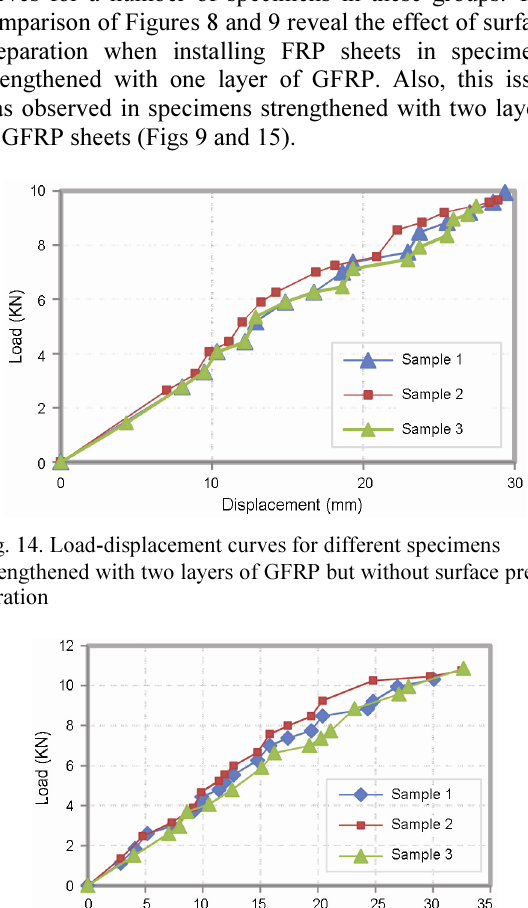
Fig. 19. Load-displacement curves for FRP-strengthened speci- mens with two layers of GFRP and with longitudinal grooves of 6 mm